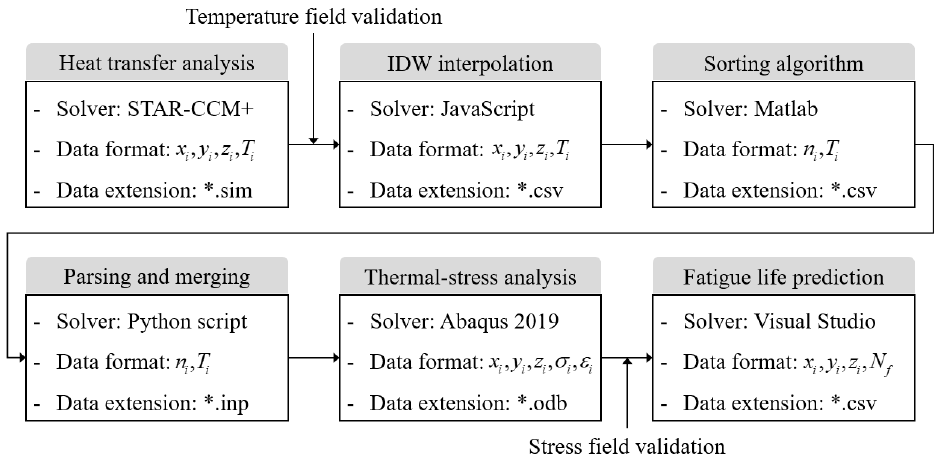
Figure 3. The procedure for one-way coupling fluid–structure interaction simulations for fatigue life prediction of the die. * indicates the name of the data file.